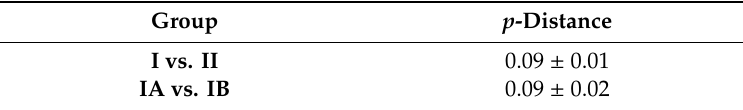
Table 5. Nucleotide sequence divergence ( p -distance) between Bov-B LINE retrotransposon groups with outgroups excluded.